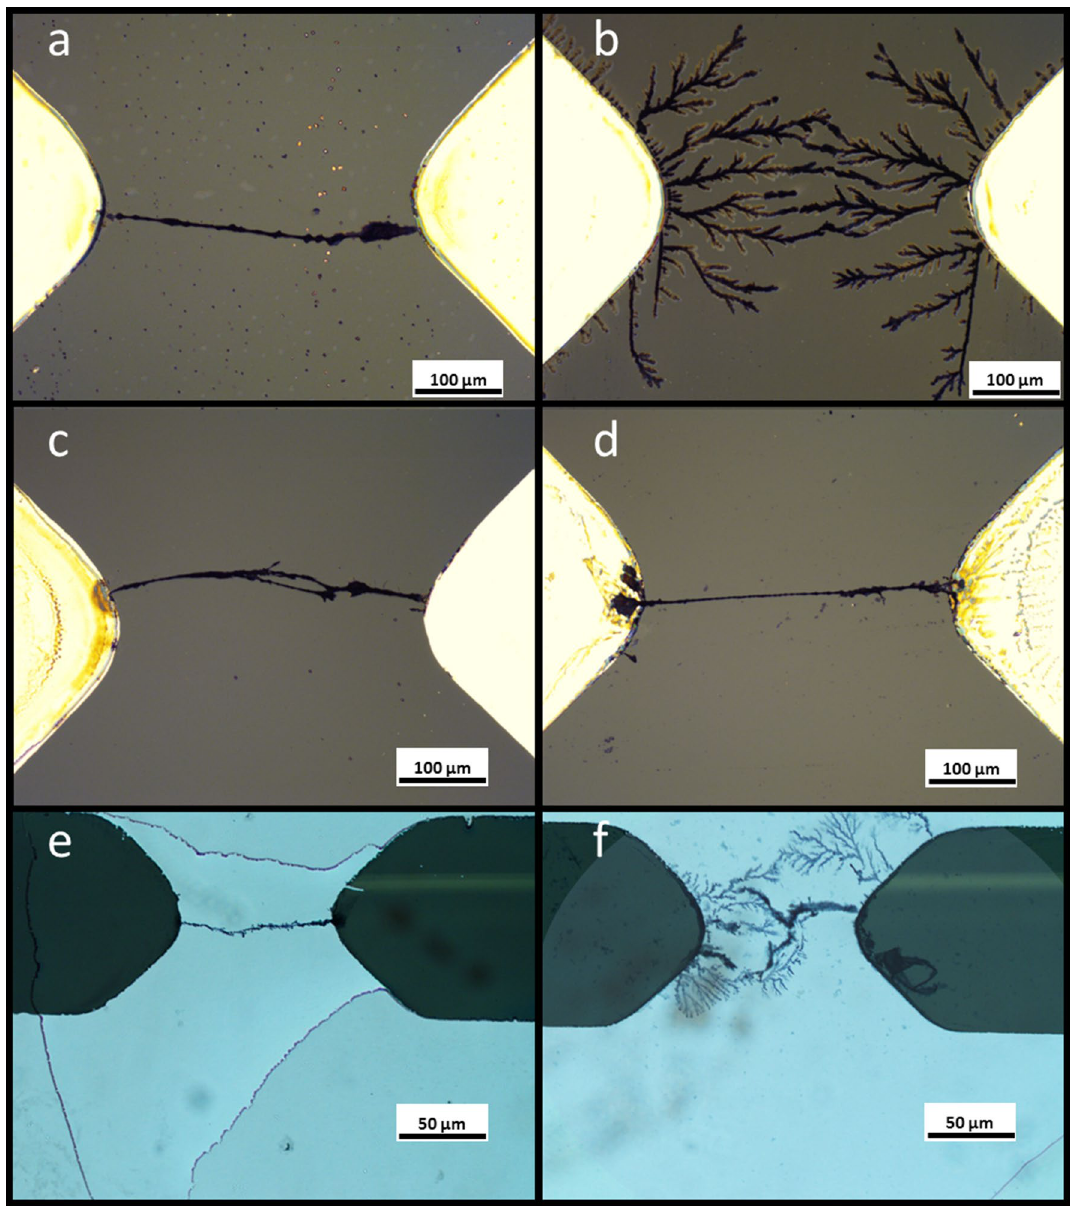
Fig. 4 Microscopic images of fibers grown in ( a ) sulfolane, b acetonitrile, c acetonitrile:sulfolane = 1:1, d acetonitrile:sulfolane = 1:3, e and f acetonitrile: sulfolane = 3:1. Illustration of the droplets in ( e ) and ( f ) were graphically enhanced to increase